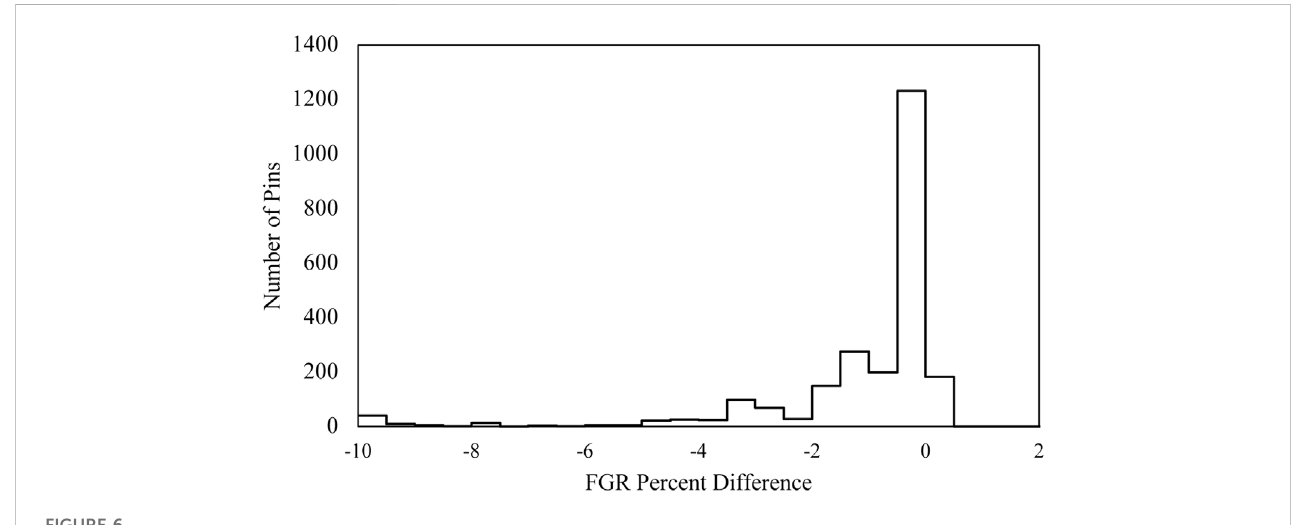
FIGURE 6 Fission gas release comparison (BISON subtracted from